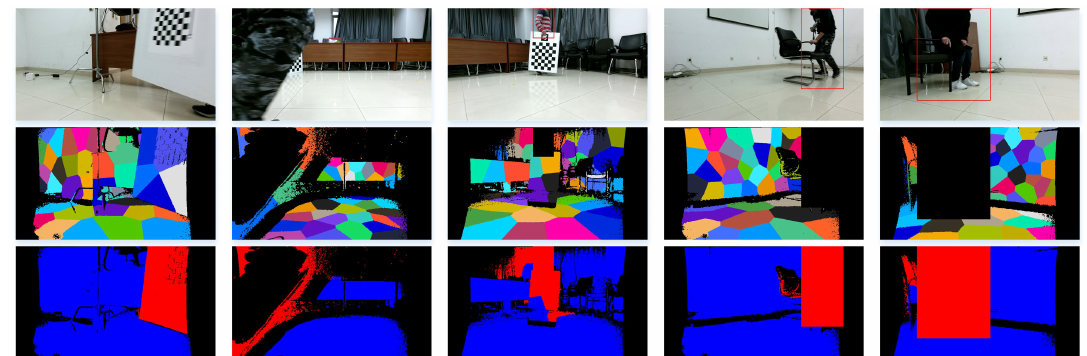
Figure 12. Typical results of the dynamic pixels culling module. The first row includes the predefined dynamic object detection results. The second row includes the results of K-means segmentation using the depth images. The third row shows the final dynamic pixel detection results. The red pixels are dynamic, the blue pixels are static, and the black pixels are pixels with invalided depth